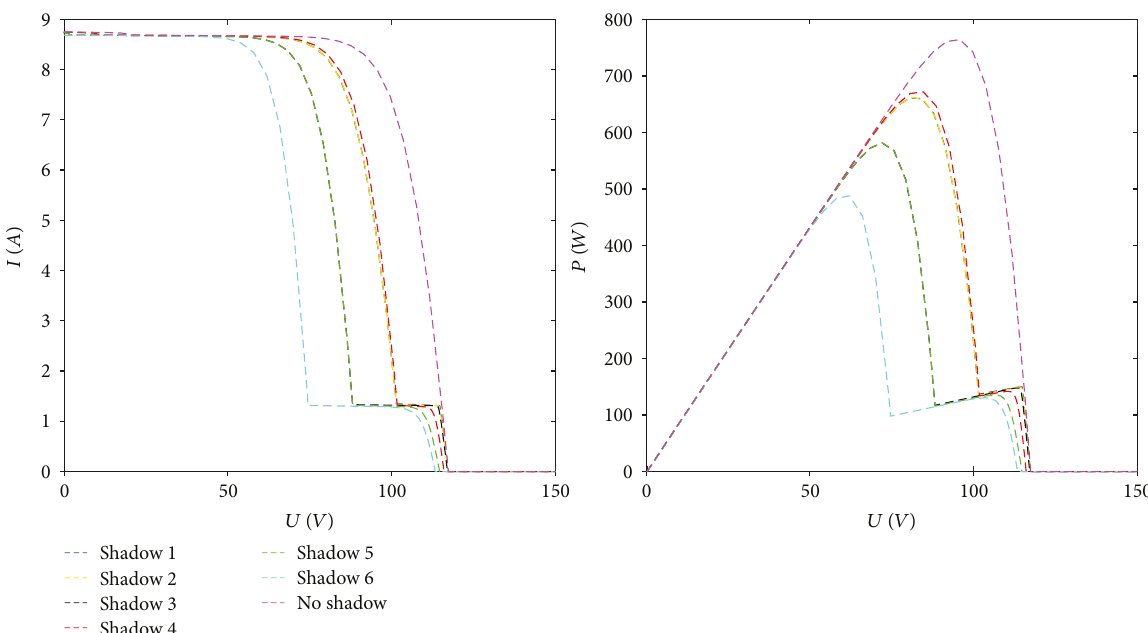
Figure 8: Simulation result for shadowing. Under the shadow conditions, the output curve presents a multipeak feature.